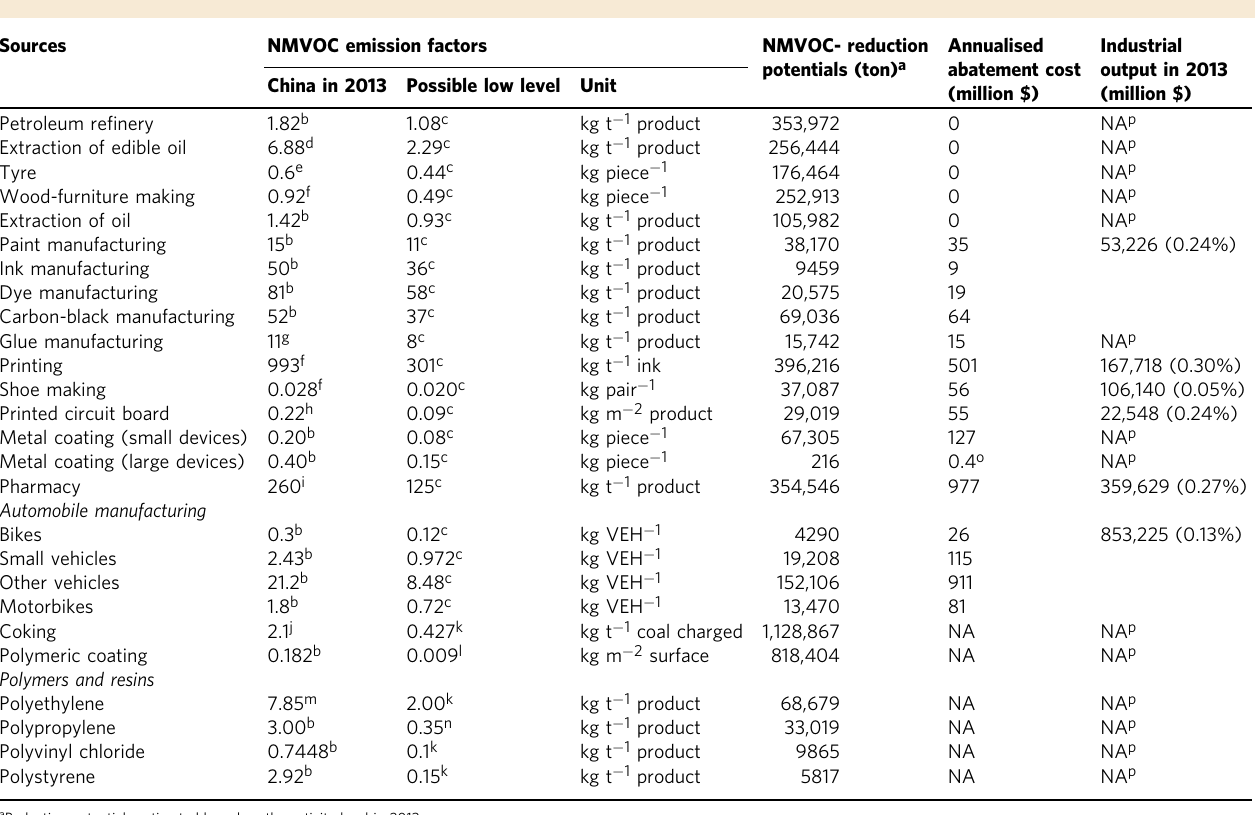
Table 1 Potentials of emission reductions and abatement